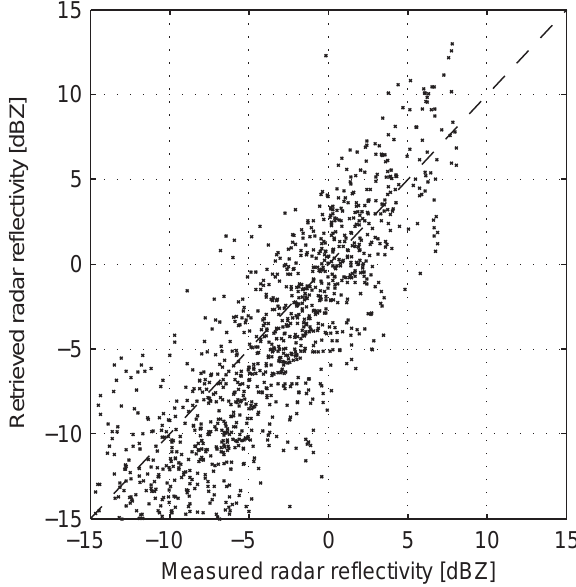
Fig. 8. Scatter plot showing observed versus lidar-retrieved radar reflectivities for 5 November 2007.